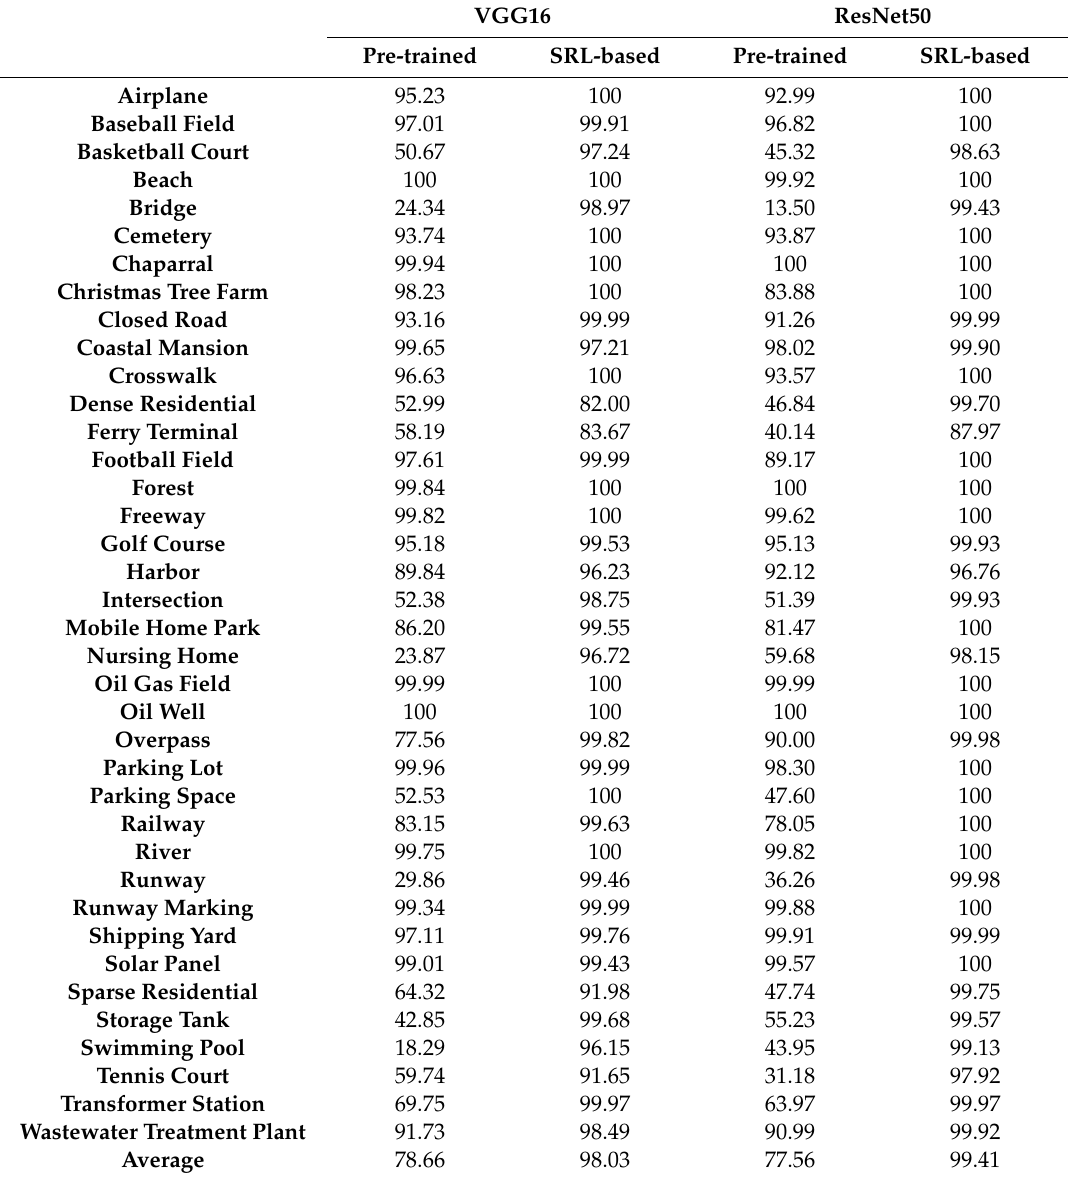
Table 4. Evaluation of mAP which is performed with VGG16 and ResNet50 on per-class in the PatternNet datasets comparing with the pre-trained